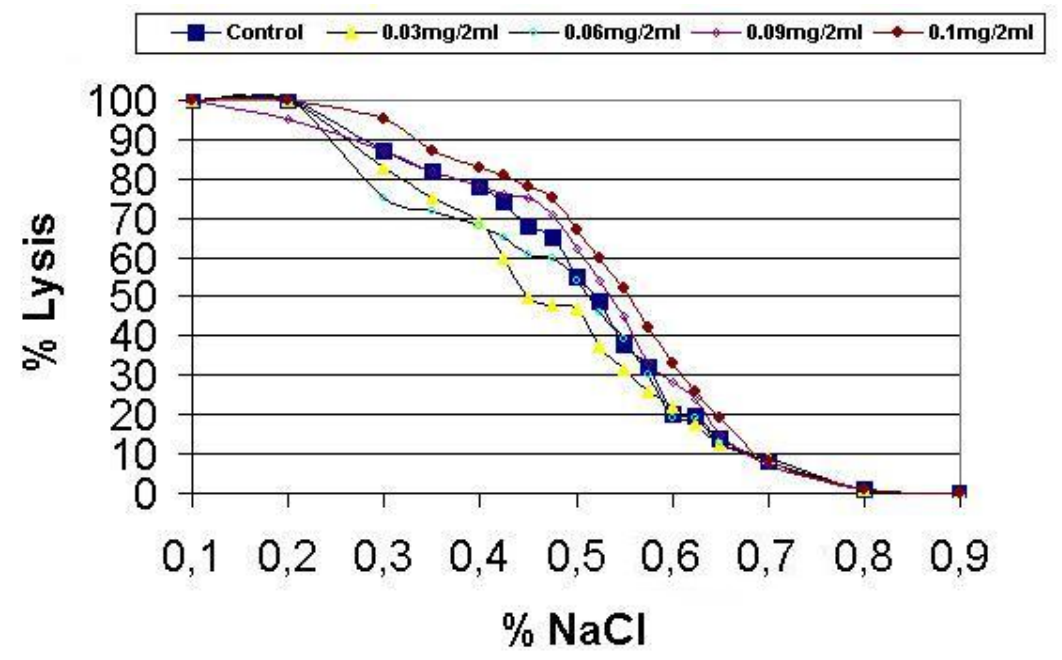
Figure 4: In vitro effect of O. doriae venom (0.03, 0.06, 0.09, and 0.1 mg / 2 ml of blood) on the osmotic fragility of RBCs after incubation for 24